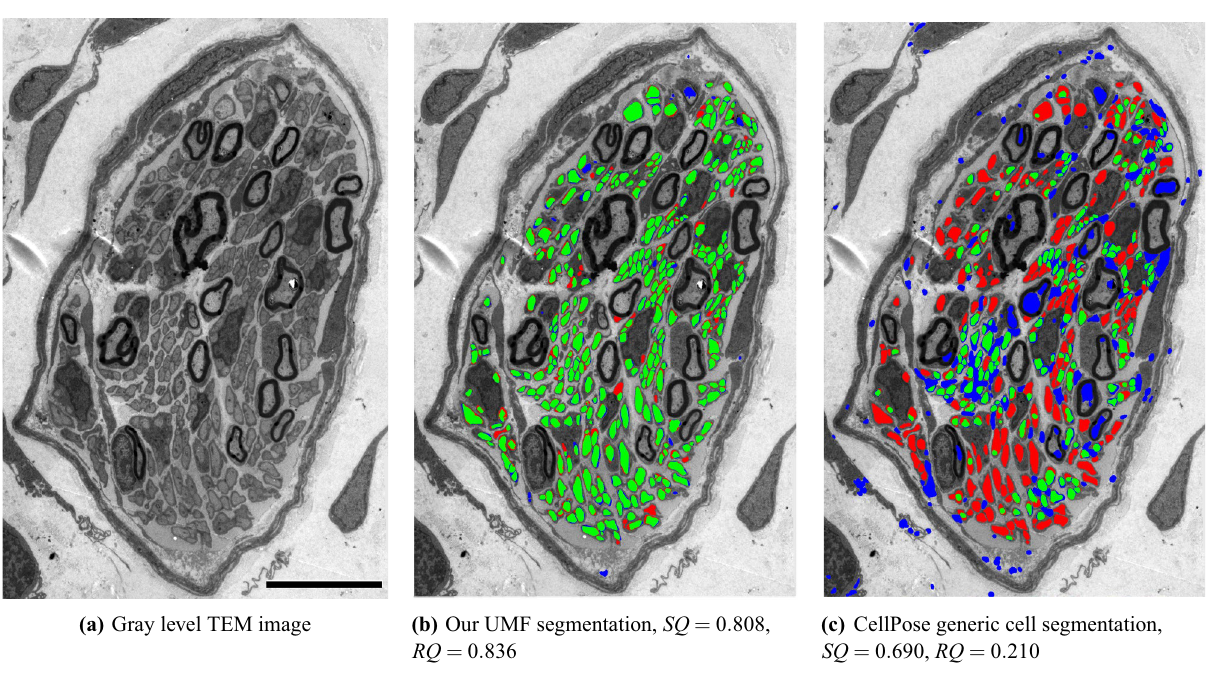
Figure 11. Comparing proposed model trained on TEM images annotated for UMFs against CellPose, a generic cell segmentation model trained on a wide range of cell images. TP, FP, and FN regions are shown in green, blue, and red, respectively. Scale bar: 10 µ